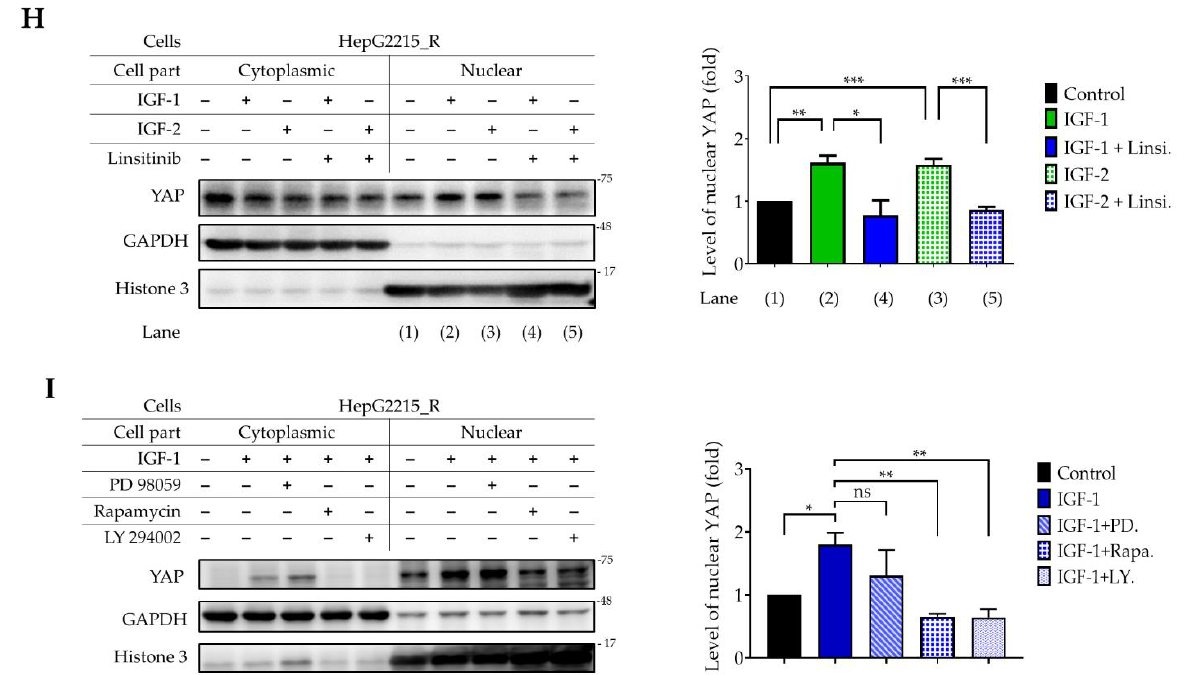
Figure 4. IGF-1R activation induces YAP nuclear translocation in sorafenib-resistant HCC cells. ( A ) Cellular localization of YAP in HepG2215 cells (left panel) and HepG2215_R cells (middle panel) by immunocytochemical staining. Cells with nuclear staining for YAP were quantified (right panel). Data are the mean ± SEM of at least nine random image fields. ( B ) The effect of IGF-1/2 (50 ng/mL, 1 h or 2 h treatment) on YAP nuclear translocalization in HepG2215_R cells. ( C ) The expression level of nuclear YAP in HepG2215_R cells was divided into three groups based on the fluorescence intensity: non, low, and high groups. ( D ) The quantitative analysis of ( B ). Data are the mean ± SEM of at least eight random image fields of (B) for each group. The effect of ( E ) IGF-1/2 (50 ng/mL, 1 h or 2 h treatment) or ( F , G ) IGF-1R silencing (shIGF-1R) on YAP protein expression in HepG2215_R cells by Western blotting assay and immunocytochemical staining. The relative quantification was normalized to the corresponding GAPDH. ( H ) The effect of IGF-1/2 (50 ng/mL, 1 h or 2 h treatment) with or without linsitinib (10 µ M) on YAP expression in cytoplasmic and nuclear fractions of HepG2215_R cells. ( I ) The effect of signaling blockages targeting PI3K (ly294002), mTOR (rapamycin), and ERK (PD98059) on YAP nuclear translocation in HepG2215_R cells under IGF-1/2 treatment. The quantification of nuclear YAP from Western blotting is analyzed in the right panel. * p < 0.05, ** p < 0.01, *** p < 0.001, and **** p < 0.0001 by Student’s t